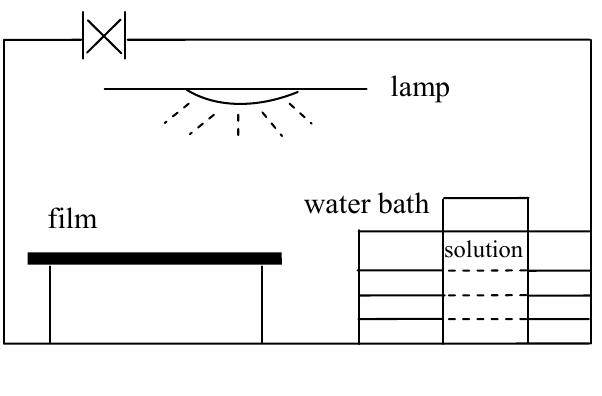
Figure 7. Schematic representation of gas-phase photografting reactor design (Reproduced with permission from [89]. Copyright 2002 Wiley).